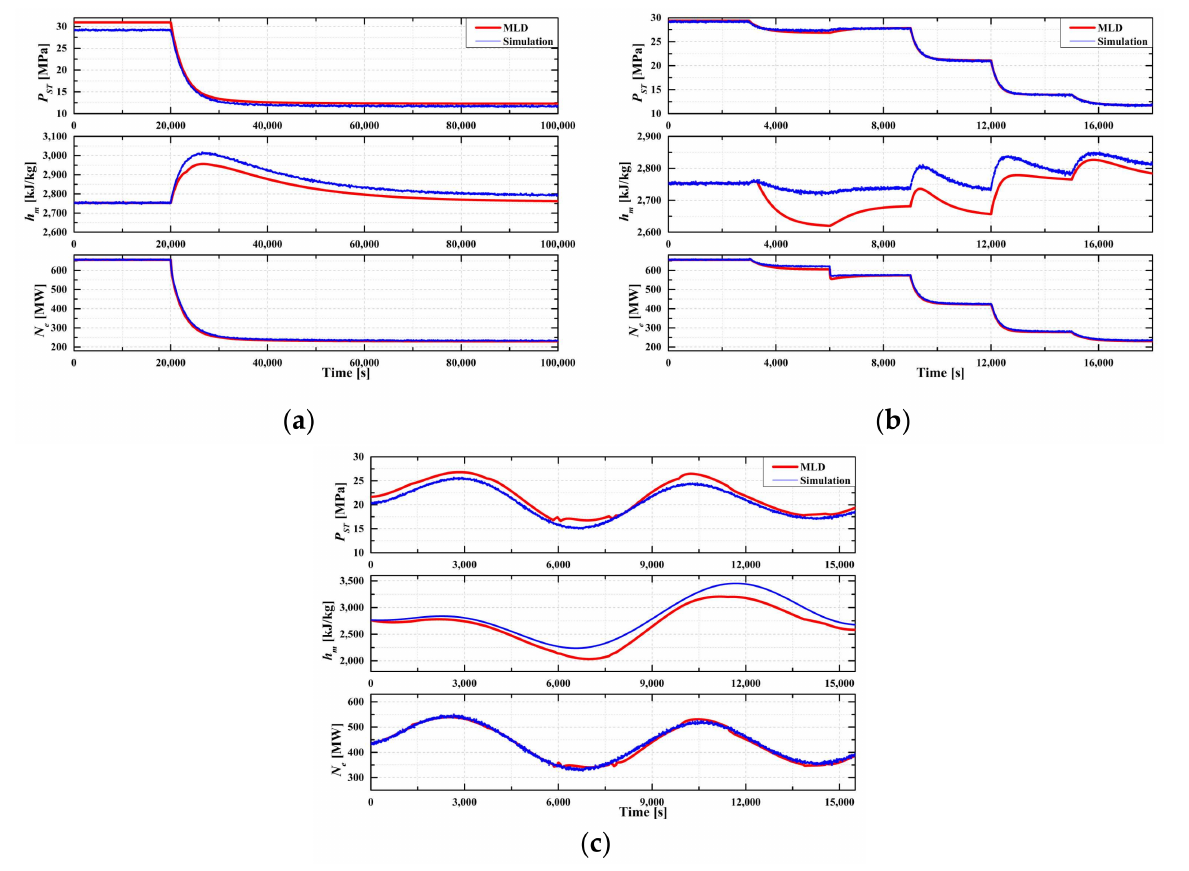
Figure 8. Comparison between the MLD model and the simulation model of 660-MW ultra- supercritical circulating fluidized bed boiler unit. ( a ) step from the BMCR to the THA40% working condition; ( b ) step through the BMCR, BECR, THA100%, THA75%, THA50%, and then to the THA40% working condition; ( c ) a sine function with frequency (8 × 10 − 4 [rad/s], 4 × 10 − 4 [rad/s], 8 × 10 − 4 [rad/s], 12 × 10 − 4 [rad/s]) and amplitude (13, 60 [Nm 3 /s], 80 [kg/s], 0.025 [ × 100%]) is taken as the input at the steady-state point ( u B = 56.65, u A = 348 [Nm 3 /s], u W = 364.1 [kg/s], u T = 0.865 [ ×